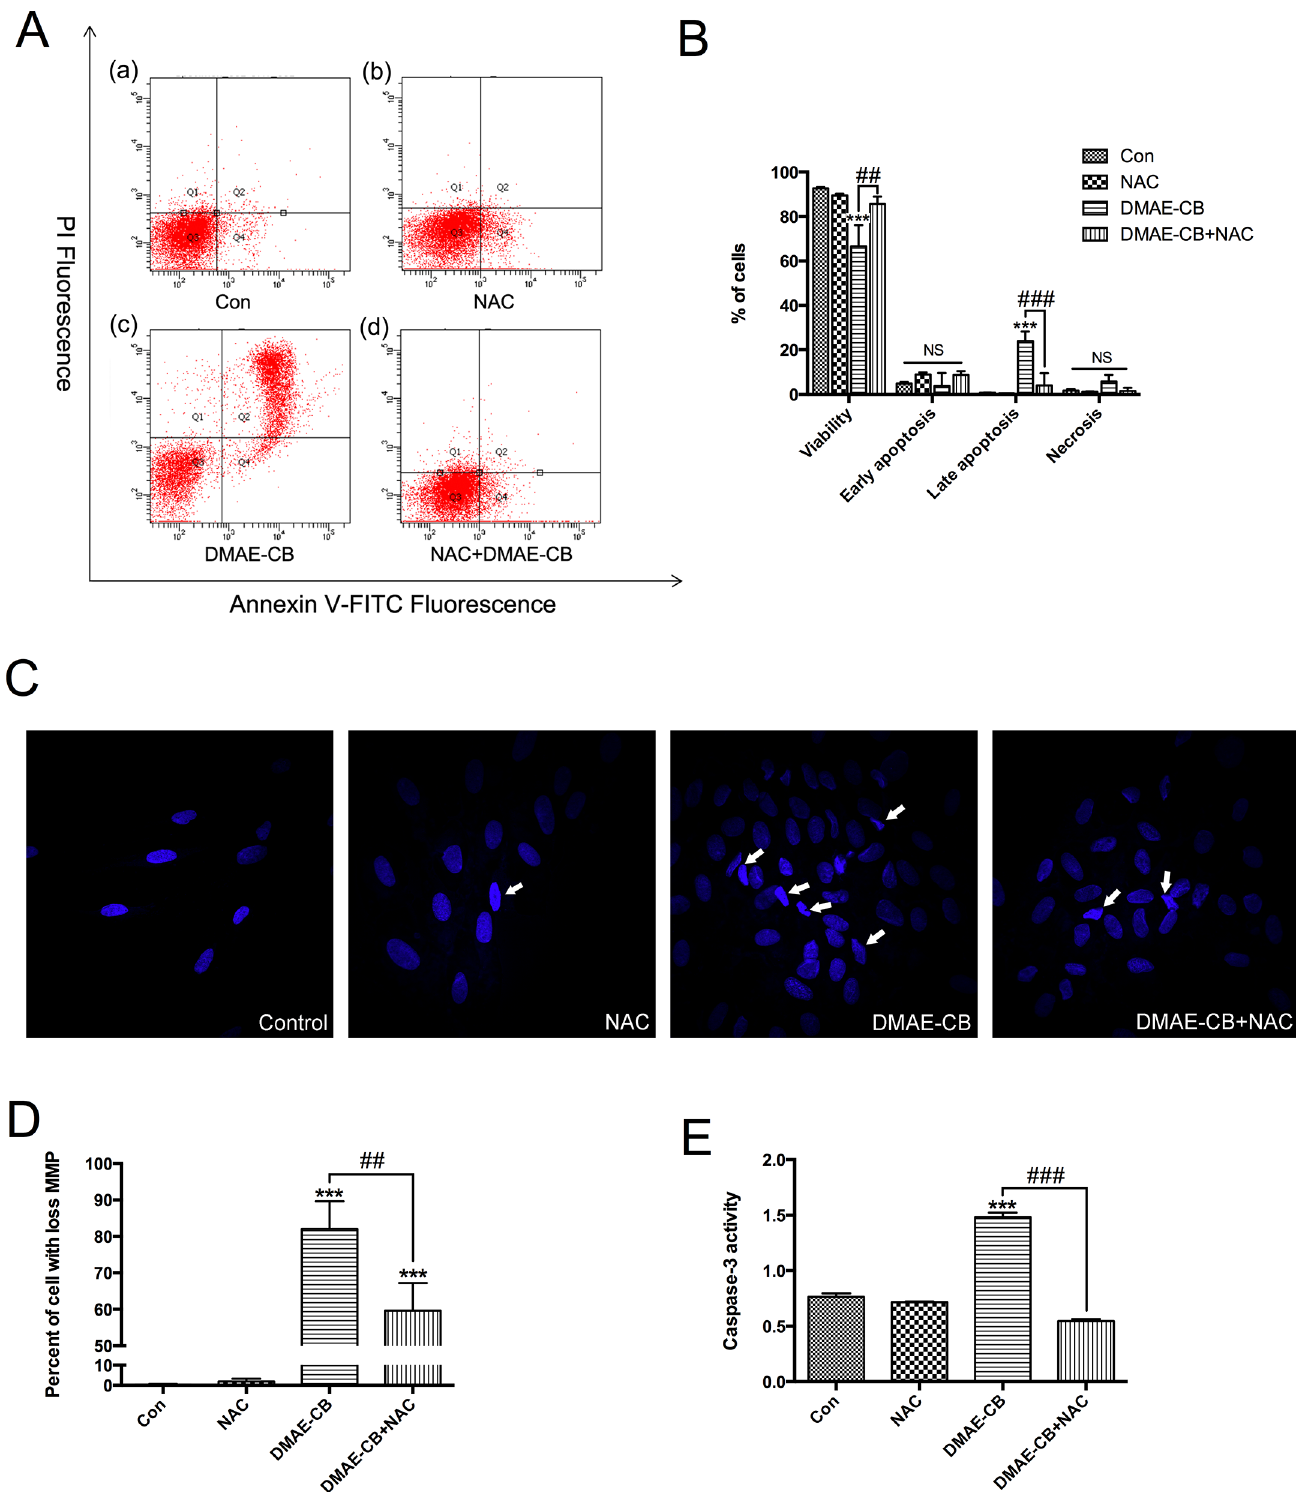
Fig 4. DMAE-CB induced apoptosis and the rescuing effect of NAC. A. Typical graphs of Annexin V/ PI staining for each group. The viable cells (Q3; Annexin V - ; PI - ), early apoptosis cells (Q4; Annexin V + ; PI - ), late apoptosis cells (Q2; Annexin V + ; PI + ) and necrosis cells (Q1; Annexin V - ; PI + ) are shown in each quadrant. B, statistical analysis of three independent Annexin V/PI staining analysis. C. Morphological changes of hDPCs. Cells pointed by arrows